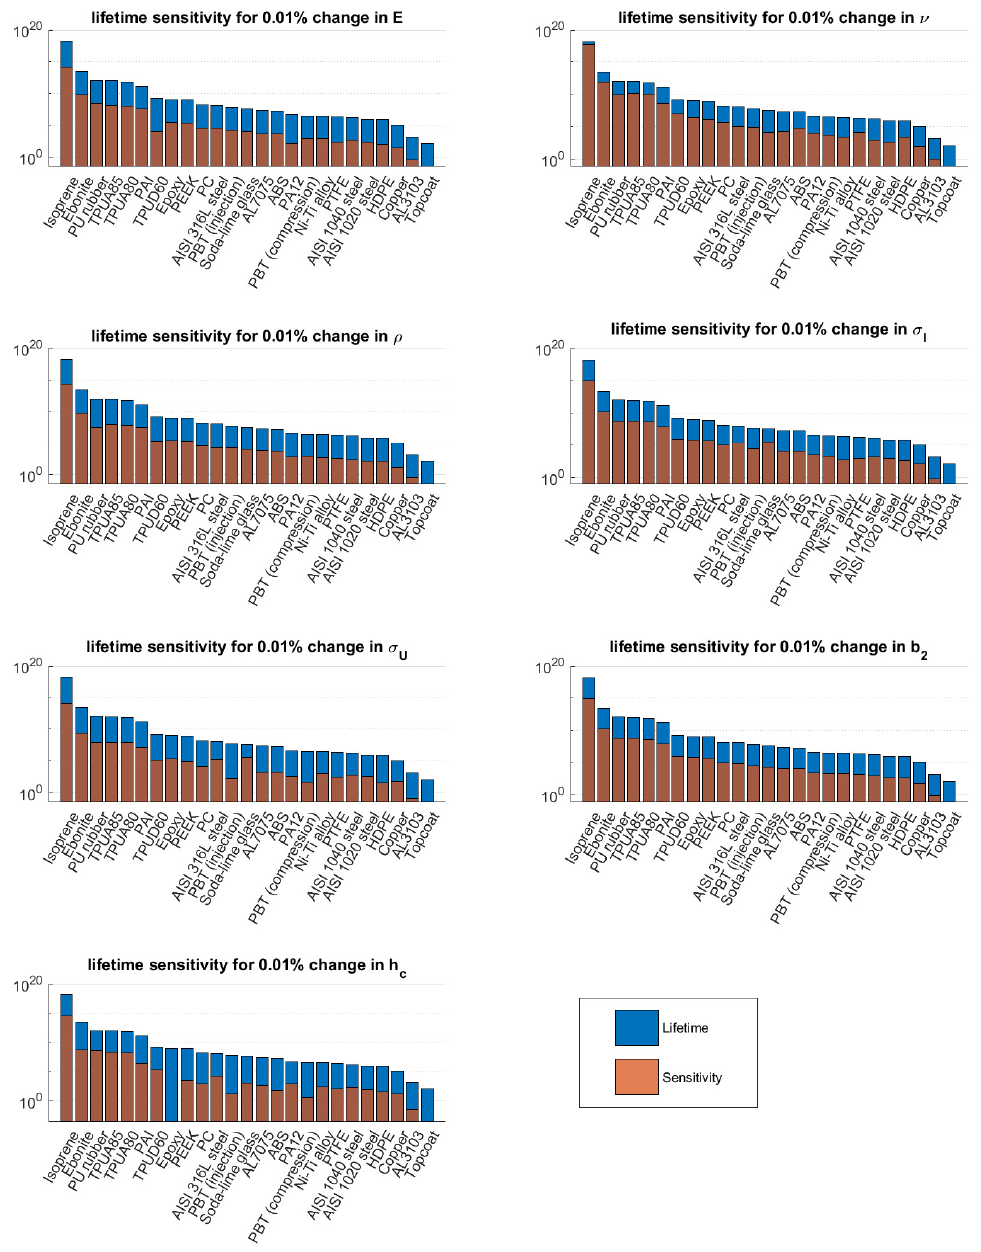
Figure 7. Global sensitivity analysis for the materials considered in Table